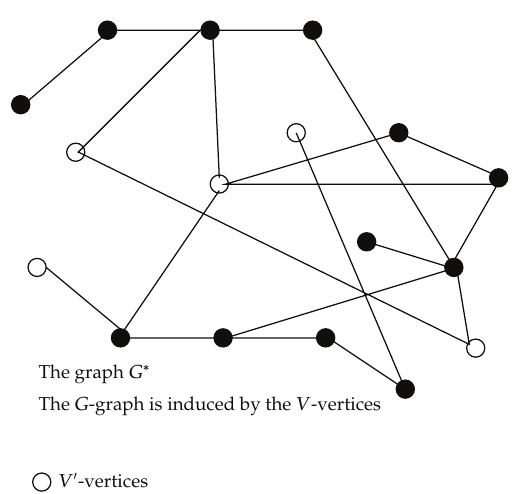
Figure 5: The beginning of the construction of W graph from G ∗ ∈ G